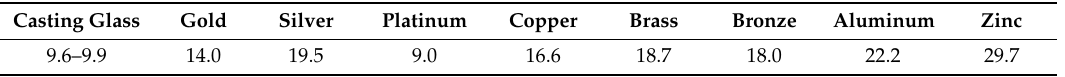
Table 1. Comparison of the linear thermal expansion coefficient of most common metals and glass used by artists.